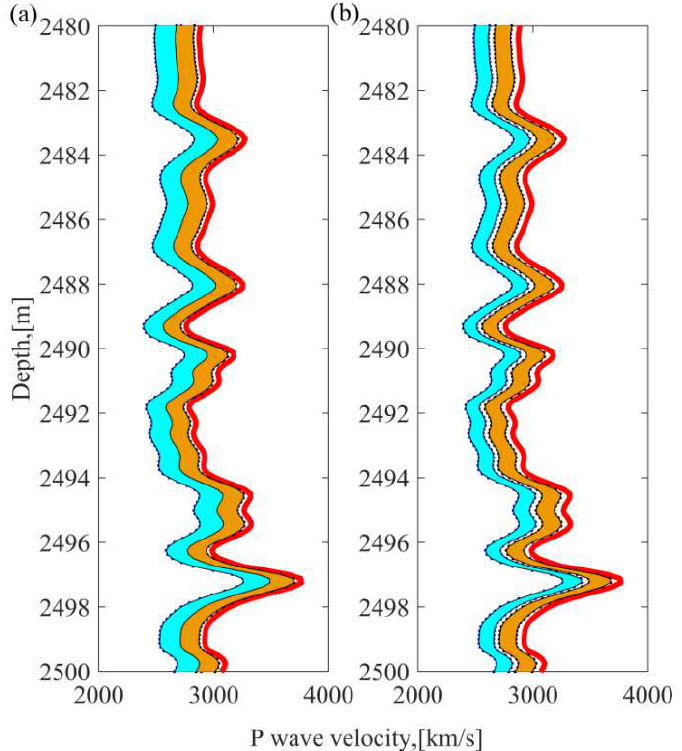
Figure 6. Velocity variation from the pore fluid dissolution model and the constant Q model. The orange area is the velocity range of the constant Q model. The cyan area is the velocity range of the pore fluid dissolution model. ( a ) Porosity ranges from 0.04 to 0.08, gas saturation is 0.25%, ( b ) porosity is 0.08, gas saturation ranges from 0.15% to 0.25%.